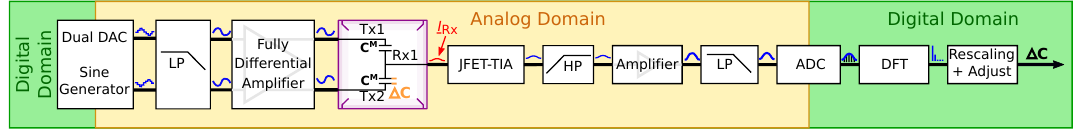
Figure 7: Measurement concept for the differential capacitance ∆ C